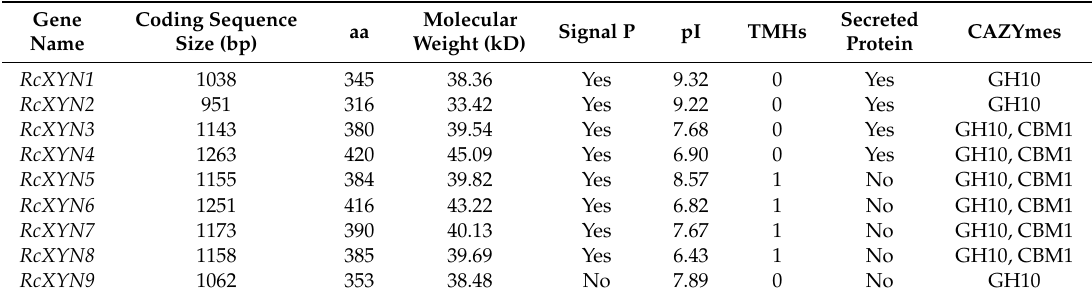
Table 1. Characteristics of nine glycoside hydrolase 10 (GH10) xylanase genes ( RcXYNs ) in Rhizoctonia